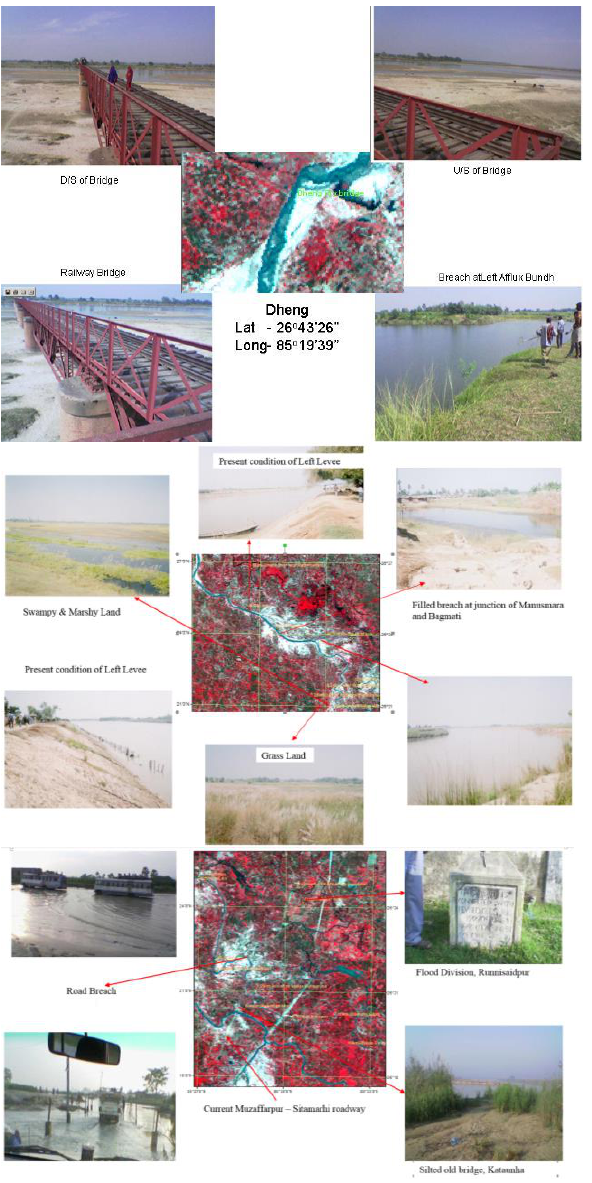
Fig. 5: Field pictures of study area, showing inflow point Dheng, breach points and one of the cross sections at Runni Saidpur (Source: Rastogi and Thakur, field survey 2006). Rating curve at Dheng Exponential equation is used to draw rating curve between measured sate and discharge data. Table 3: Peak water level and flow at Dheng site